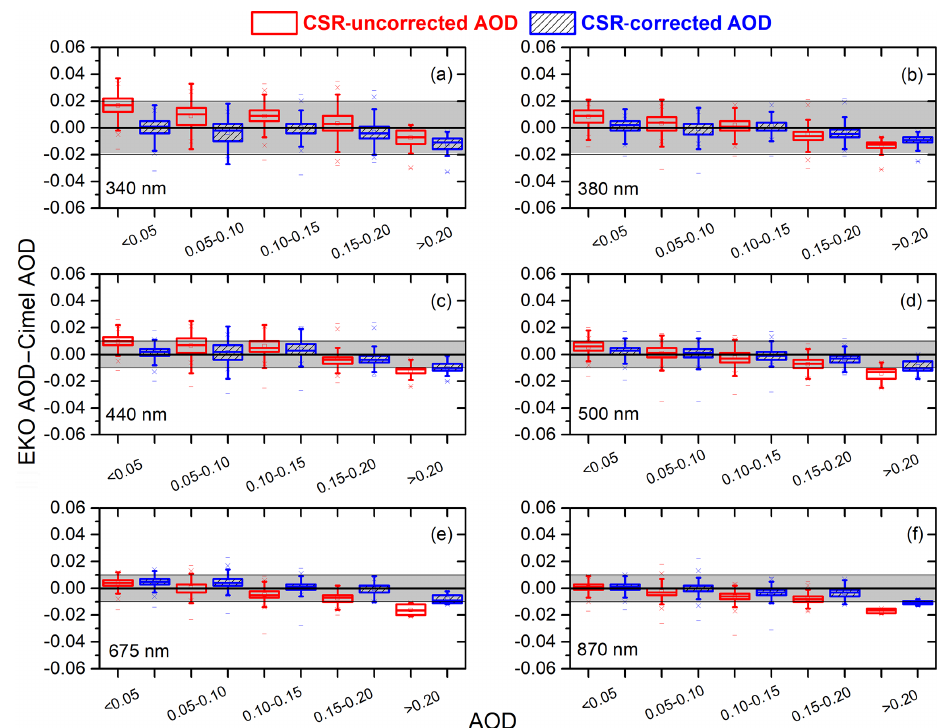
Figure 10. Box plot of the differences between the EKO AOD with (no) CSR corrections and Cimel AOD versus AOD for the period April– September 2019 at IZO in blue (red). Lower and upper boundaries for each box are the 25th and 75th percentiles; the solid line is the median value; the crosses indicate values out of the 1.5-fold box area (outliers); and hyphens are the maximum and minimum values. Shadings show the range of uncertainty of Cimel ( ± 0 . 02 for the UV range and ± 0 . 01 for VIS and near-IR ranges; Eck et al.,